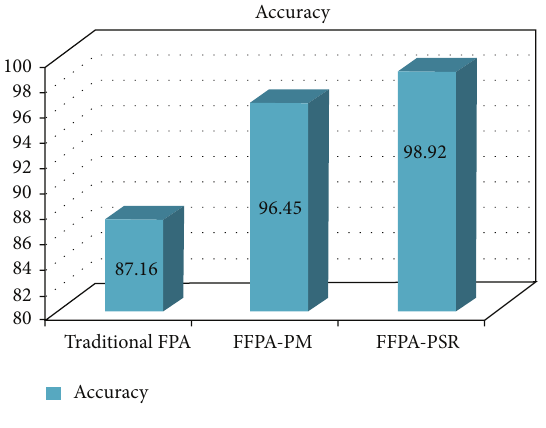
Figure 4: Comparison of